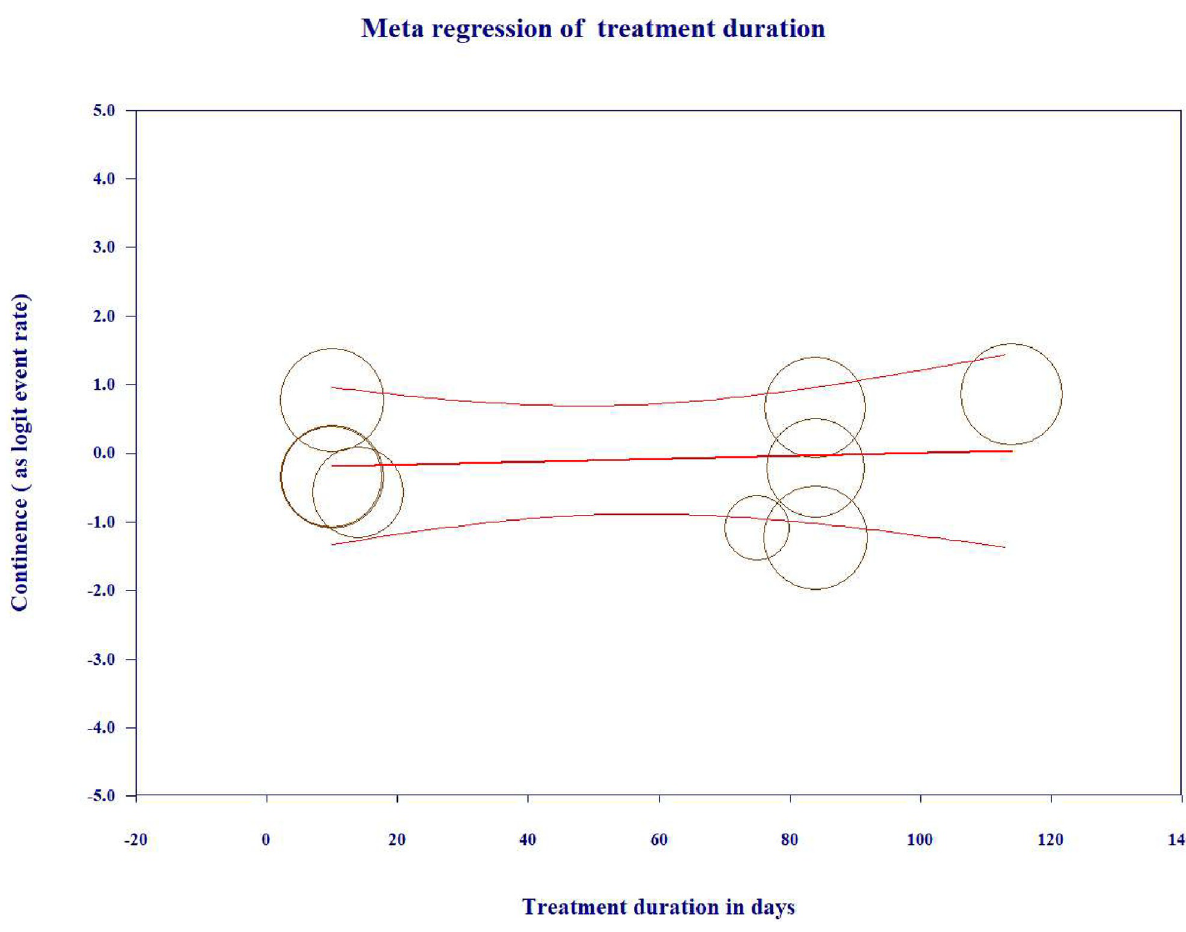
Fig 4. Metaregression of treatment duration in days as a predictor of the variation across studies in continence rates.